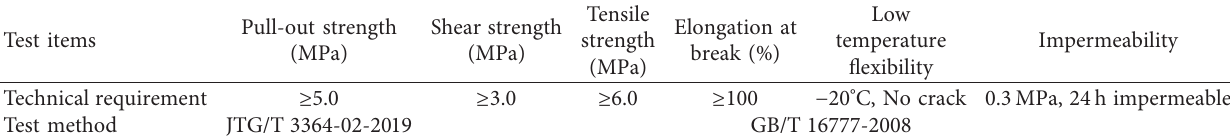
Table 2: Key performance indicators recommendation of resin waterproof adhesive layer. Test